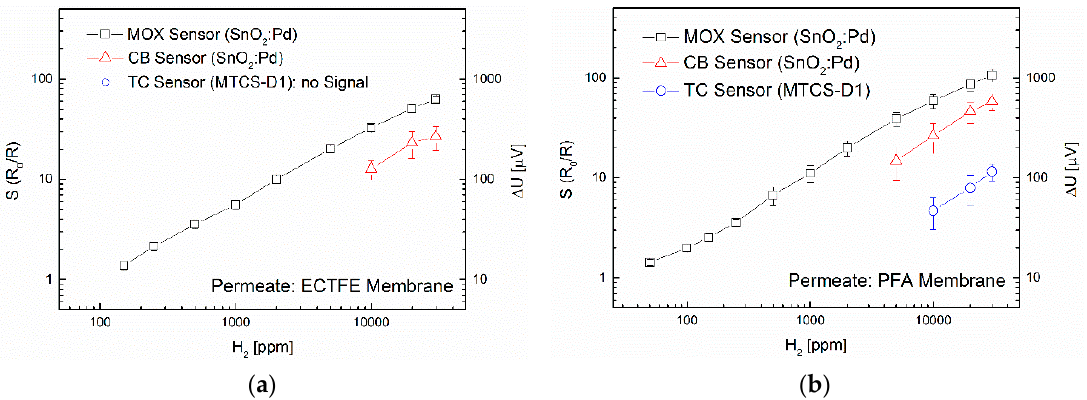
Figure 6. ( a ) Sensor signals upon exposure of the ECTFE membrane to H 2 (concentration range from 150 ppm to 30,000 ppm); ( b ) Sensor signals upon exposure of the PFA membrane to H 2 (concentration range from 50 ppm to 30,000 ppm).